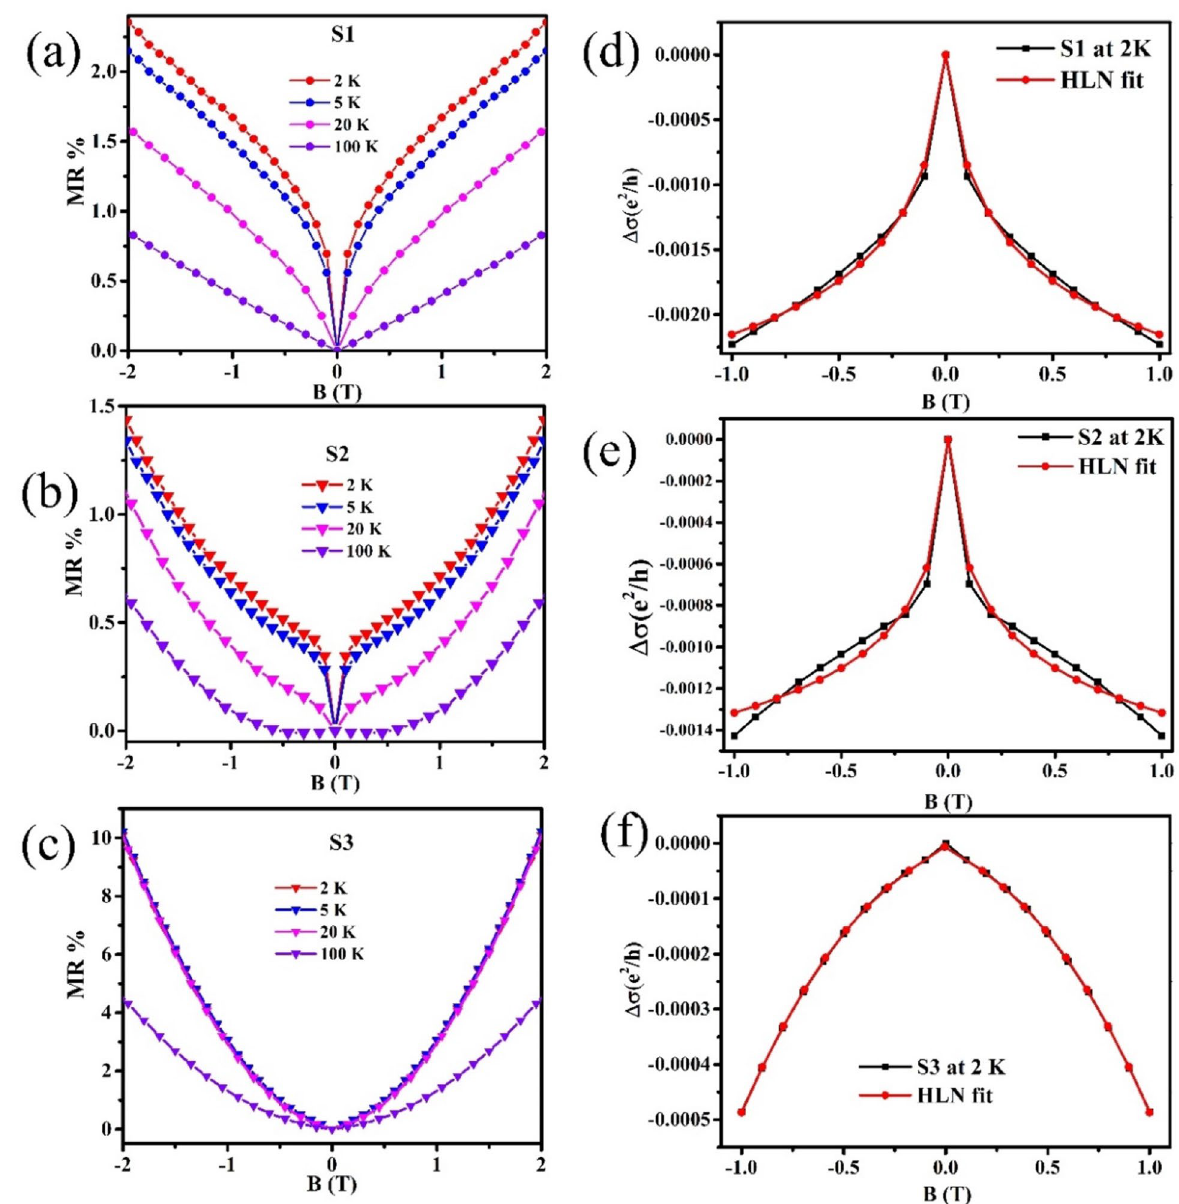
Figure 6. ( a – c ) Magneto-resistance (MR) as a function of the perpendicular magnetic field (− 2 to 2 T) at T = 2–100 K for Bi 2 Se 3 film samples S1, S2 and S3, respectively. ( d, e ) The HLN fitted magneto-conductance data for samples S1 and S2, respectively. ( f ) The modified HLN fitted magneto-conductance curve for thicker sample